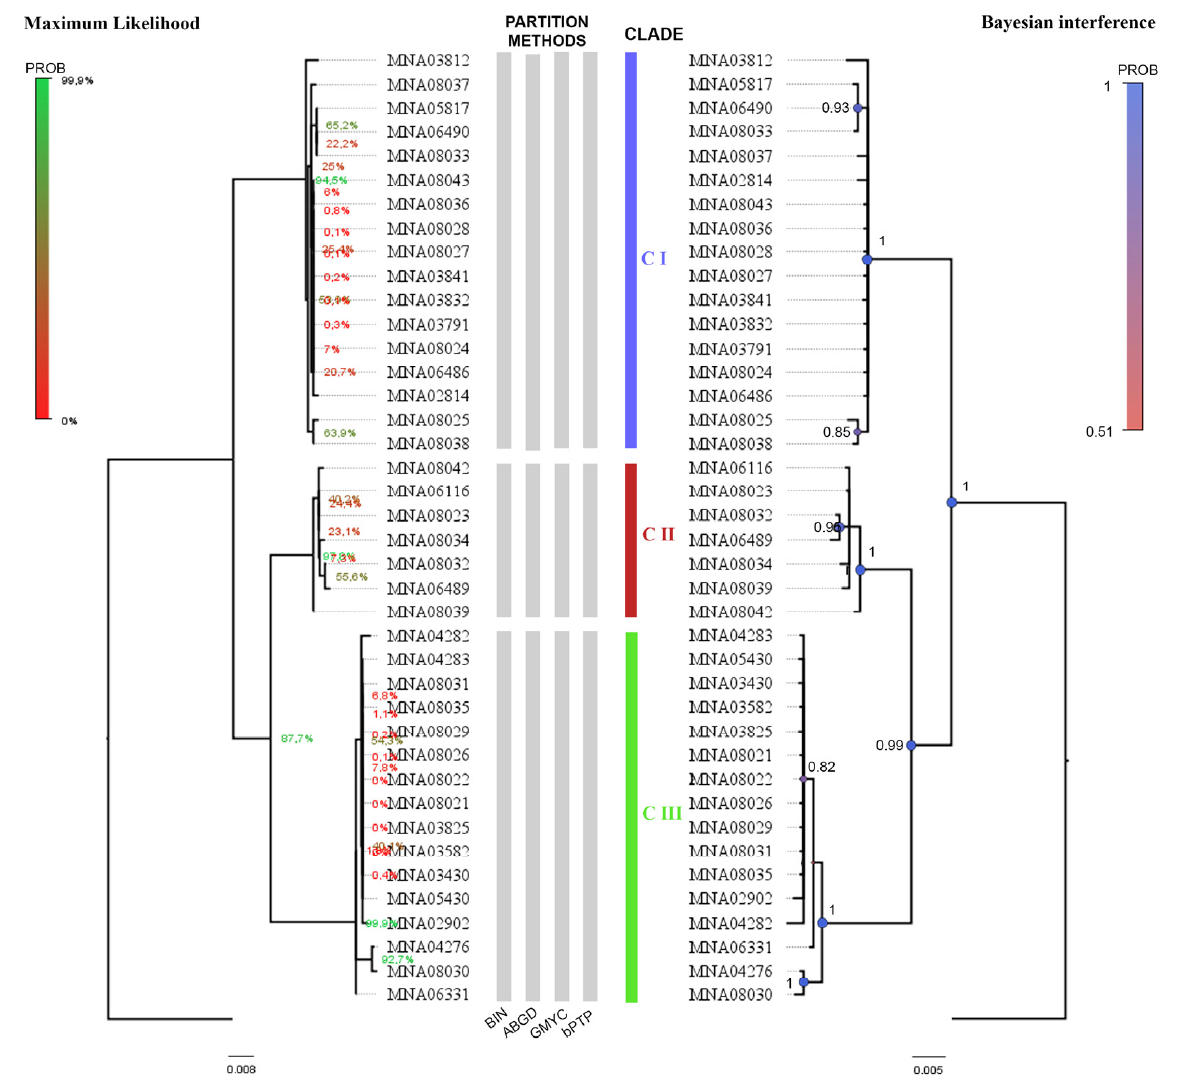
Figure 2. Tree topology comparison of maximum likelihood ( left ) and Bayesian interference ( right ). Posterior probability node values are showed on the tree with corresponding legend for each